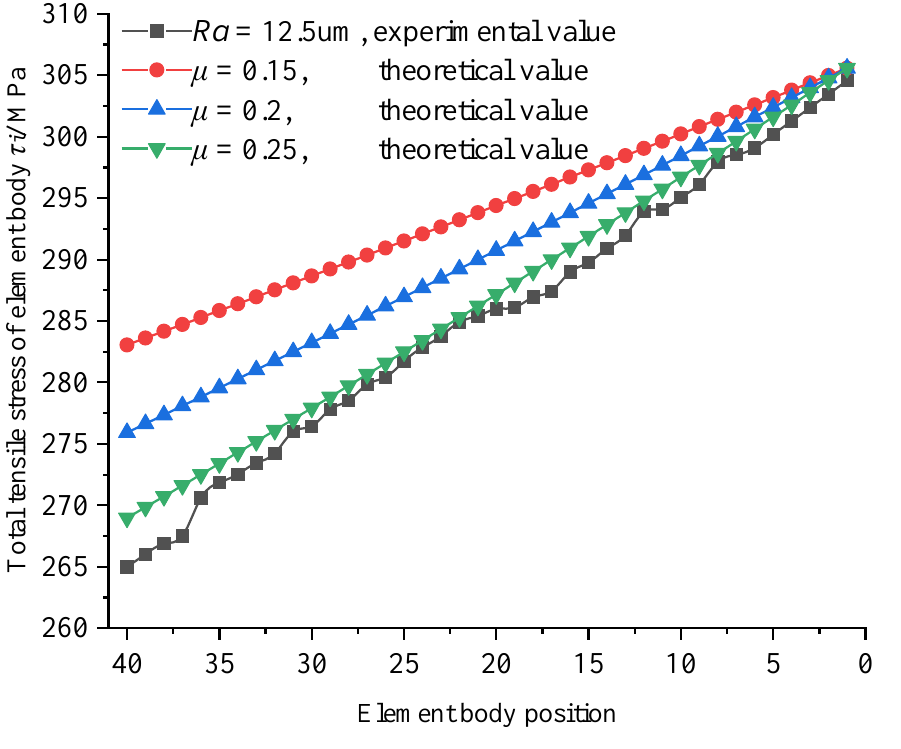
Figure 16. Variation curve of tensile stress.